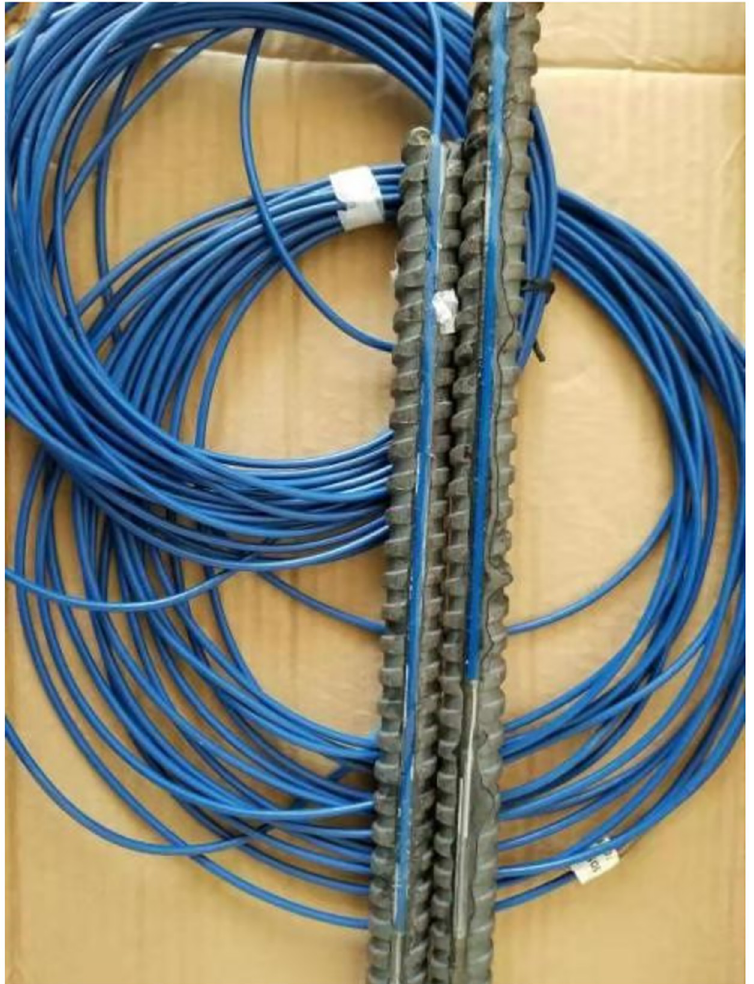
Fig 6. The bolt with embedded